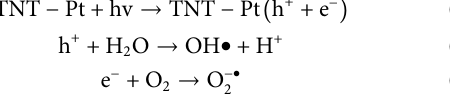
Frontiers in Chemistry |